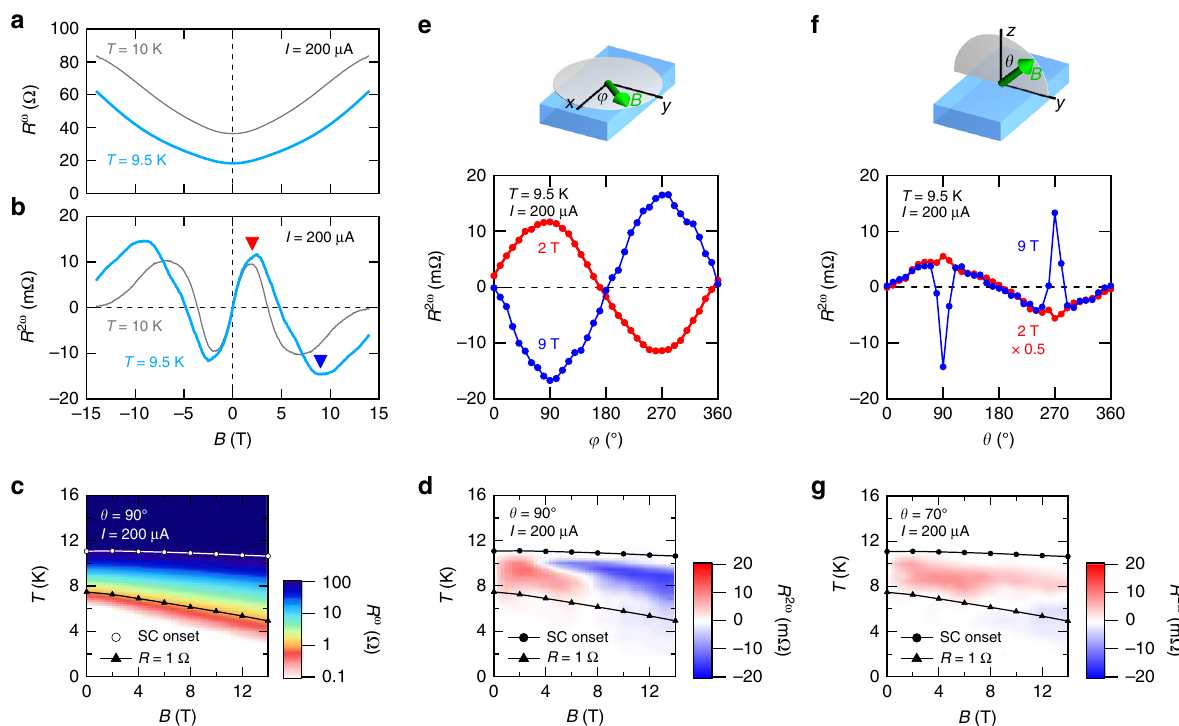
Fig. 3 Nonreciprocal transport at high magnetic fi elds. a The magnetic fi eld dependence of fi rst harmonic resistance R ω at T = 9.5 K (light blue) and T = 10 K (gray) measured under I = 200 μ A. b The magnetic fi eld dependence of second harmonic resistance R 2 ω . at T = 9.5K and T = 10 K measured under I = 200 μ A. The red and blue triangles represent the positive and negative peaks at around B = 2 T and B = 9 T, respectively. c The contour plot of R ω in the plane of magnetic fi eld and temperature at θ = 90° ( B || y , de fi ned in f ) measured under I = 200 μ A. The superconducting onset and R = 1 Ω are shown in circle and triangle, respectively. d The contour plot of R 2 ω in the plane of magnetic fi eld and temperature at θ = 90° measured under I = 200 μ A. e The in-plane magnetic- fi eld direction dependence of R 2 ω at B = 2 T (red) and B = 9 T (blue) within xy plane measured under I = 200 μ A. φ is de fi ned as an angle in xy plane measured from the x- axis. f The out-of-plane magnetic- fi eld direction dependence of R 2 ω at B = 2 T (red) and B = 9 T (blue) within zy plane measured under I = 200 μ A. θ is de fi ned as an angle in zy plane measured from the z- axis. g The contour plot of R 2 ω in the plane of magnetic fi eld and temperature at θ = 70° measured under I = 200 μ